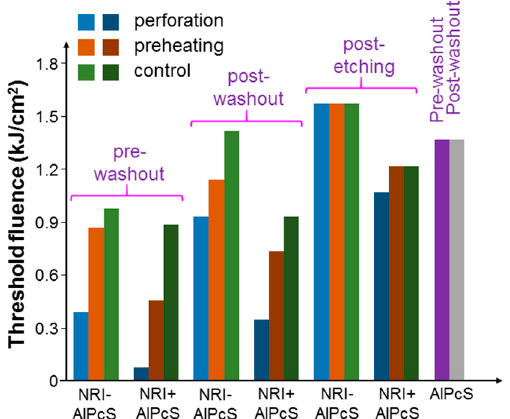
Figure 11. Results of threshold fluence under the pre-washout, post-washout, and post-etching conditions with the illumination of the 660-nm laser when cells were incubated with NRI-AlPcS and NRI + AlPcS. Here, we also show the threshold fluences under the pre-washout and post-washout conditions with the illumination of the 660-nm laser when AlPcS alone (10 µM) was incubated with cells.